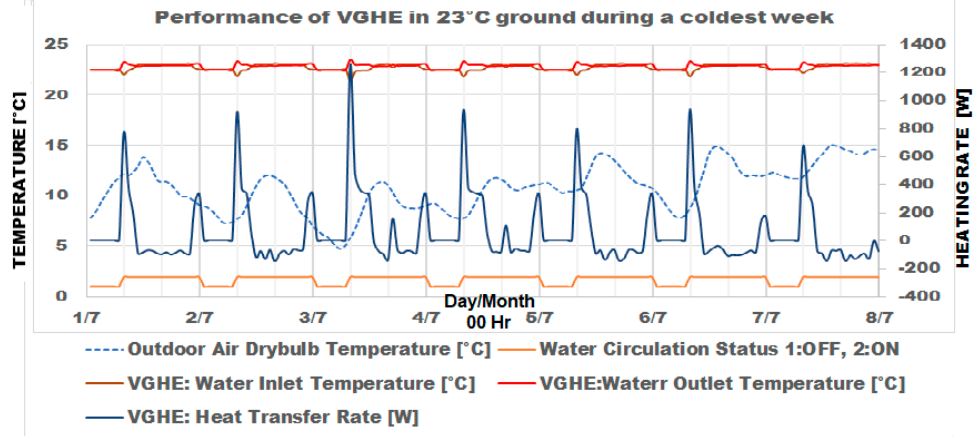
Figure 5. VGHE pump operation, heating rates and water inlet/outlet temperatures for the coldest week.